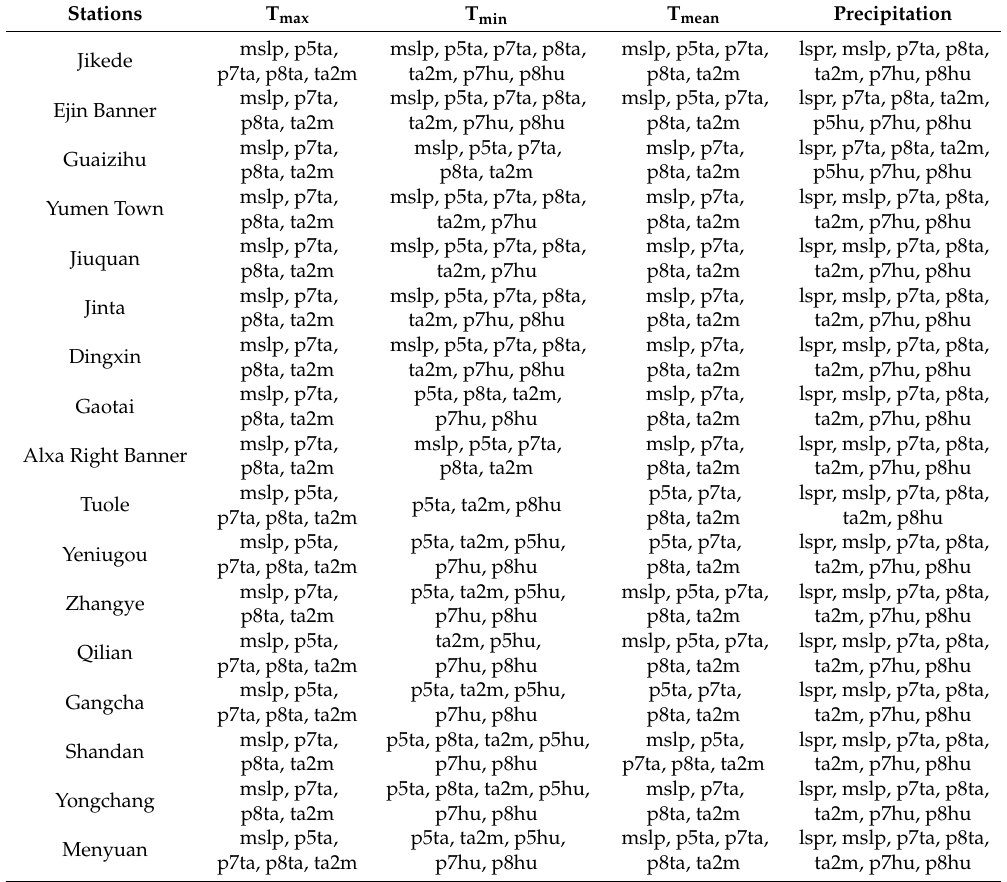
Table 3. Selected predictors according to different predictands of the 17 meteorological